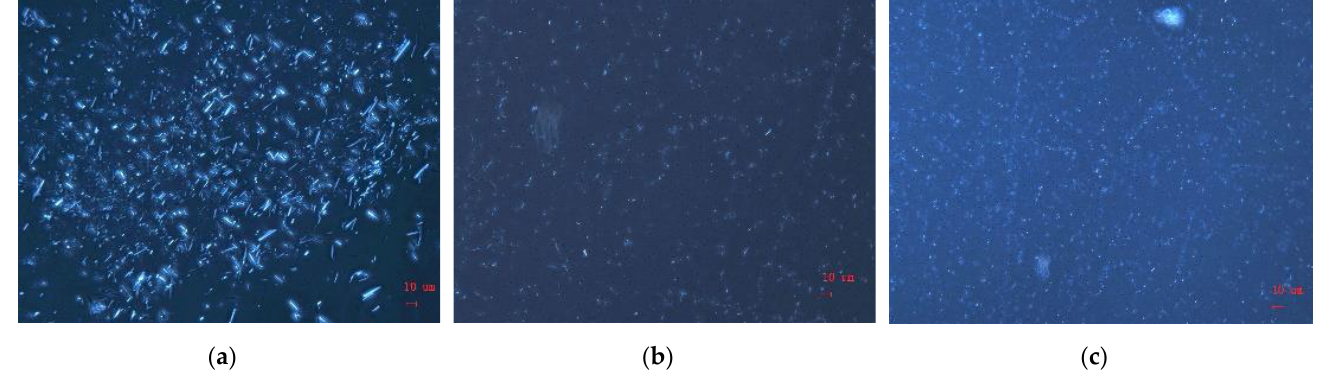
Figure 9. Photography of paraffin crystal in saturated HC of the heavy oil before and after aquather- molysis. ( a ) Blank; ( b ) Fe(III)L; ( c ) Fe(III)L + methanol.